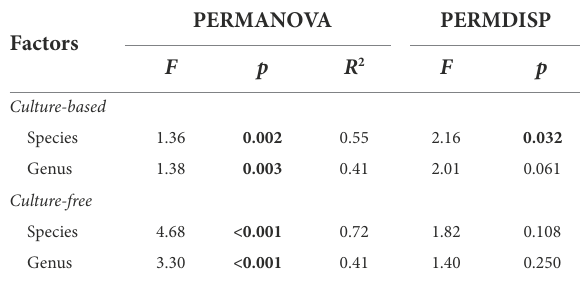
TABLE 2 Endophyte community composition differed among host